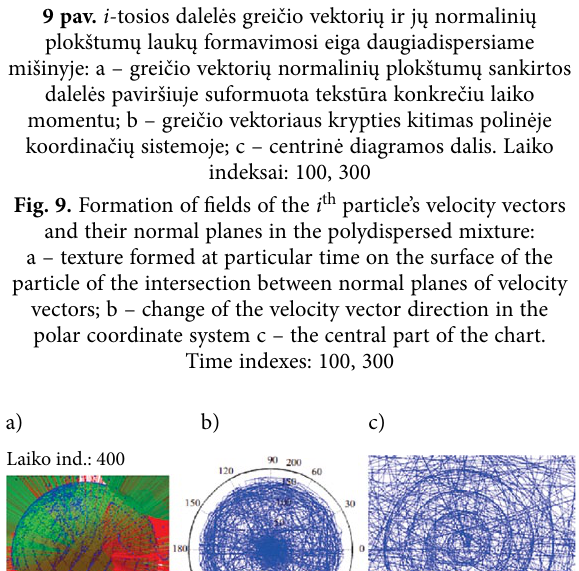
and g , when velocity vector v j j